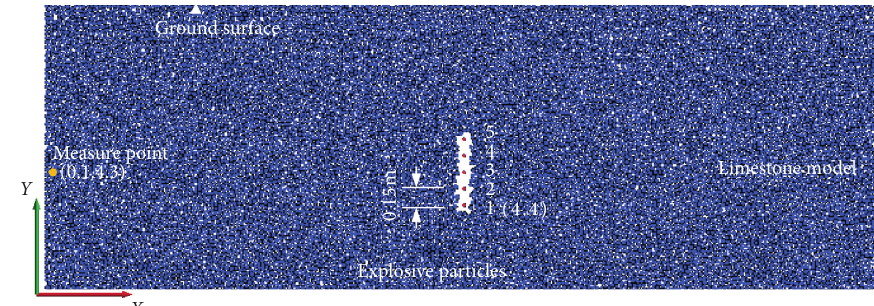
Figure 10: Particle position of measuring